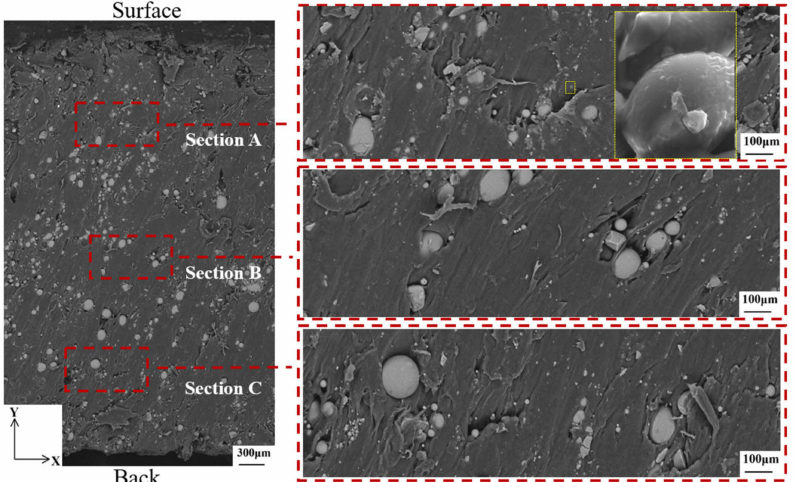
Figure 9. Microscopic morphology of the motor after ablation in the XOY direction. The larger yellow dashed rectangle is an enlarged view of the smaller yellow dashed